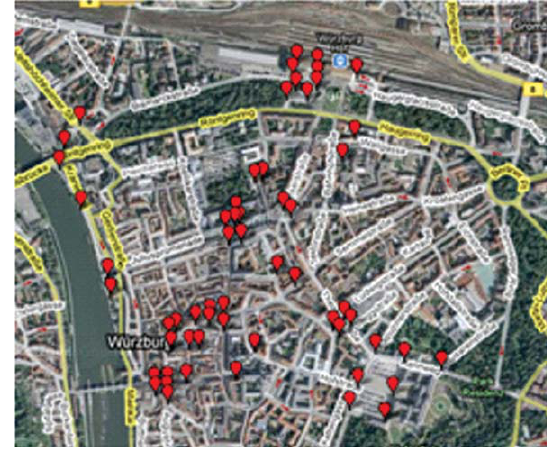
relational and geographical location information (see Figs. 10 and 11). Relational information is based on the internal street identifier and the object of